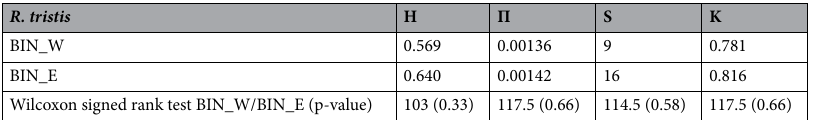
Table 1. Molecular diversity of BIN_W and BIN_E lineages of R. tristis population in the W Carpathians. The statistical significance was computed with the Wilcoxon signed rank test for paired data (p-value). H haplotype diversity, Π nucleotide diversity, S number of polymorphic sites, K average number of nucleotide differences.